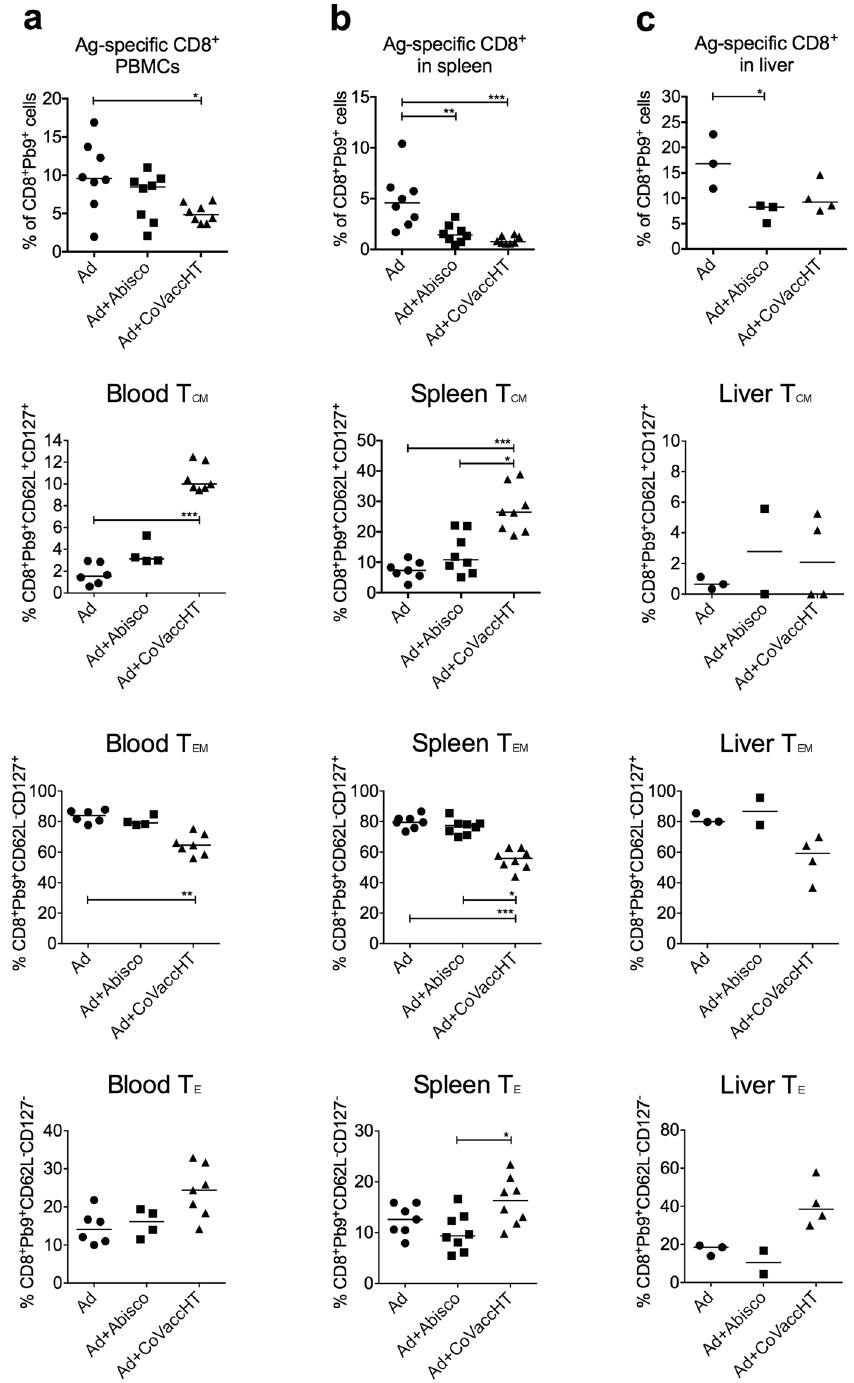
Figure 6. Memory profiles of CD8 + T cells in the peripheral blood, spleen and liver of animals vaccinated with unadjuvanted and adjuvanted Ad-ME.TRAP. BALB/c mice (n = 8) were immunized intramuscularly with Ad-ME.TRAP (5 × 10 9 vp/dose), alone or adjuvanted with Abisco ® -100 or CoVaccineHT. Proportion of Pb9-specific CD8 + T cells in the peripheral blood, spleen and liver, and their memory profiles (T E , T EM and T CM ) were evaluated by flow cytometry using Pb9-tetramer and surface markers CD127 and CD62L. The three memory cell subsets were defined as: T E = CD62L − CD127 − , T EM = CD62L − CD127 + and T CM = CD62L + CD127 + . Representative FACS data are shown in the Supplementary Figure S2c. Ranked one- way ANOVA analysis (Kruskal-Wallis) with Dunn’s test for multiple comparisons was used to assess statistical significance of the differences between groups; * p < 0.05, ** p < 0.01, *** p <